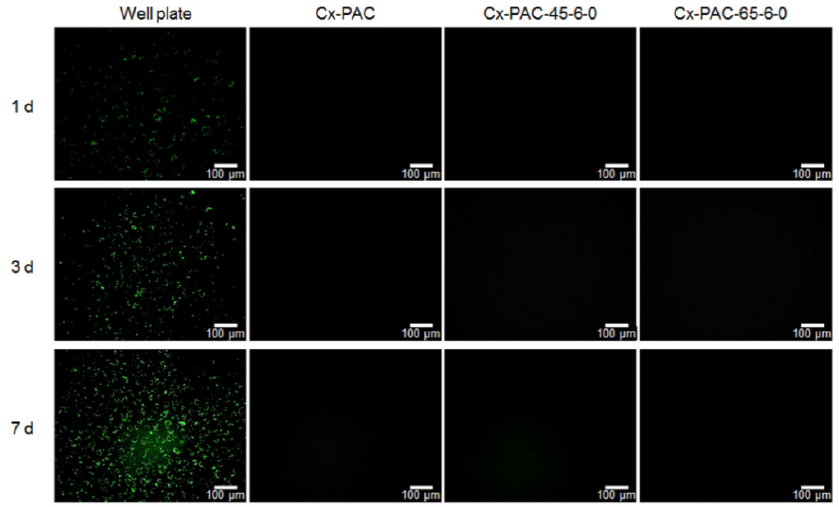
Figure 7. Fluorescent image showing PKH67 ‐ labeled HUVECs cultured for one to seven days on well plate and Cx ‐ PAC film after thermal treatment at 45 °C and 65 °C. Magnification: 200× and scale bar represents 100 μ m.